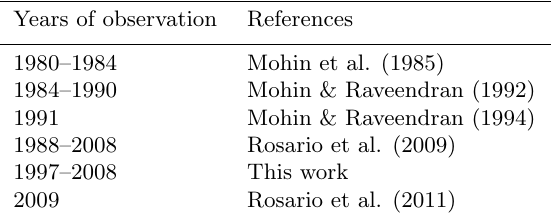
Table 1. References of the data used in this